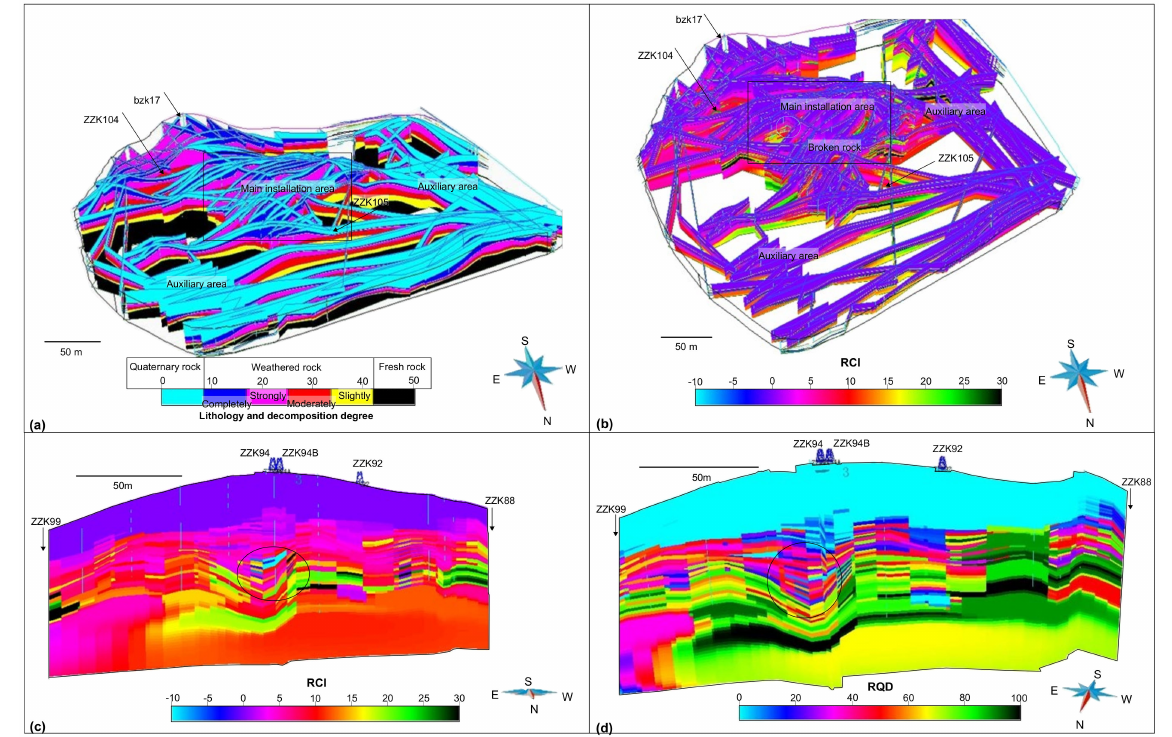
Figure 5. Geological modeling (using GOCAD software) of ( a ) weathering, ( b , c ) the RCI values, and ( d ) the RQD values. Note: for the RCI, The light blue layer represents a problematic geological body (e.g., fractured rocks or displaced